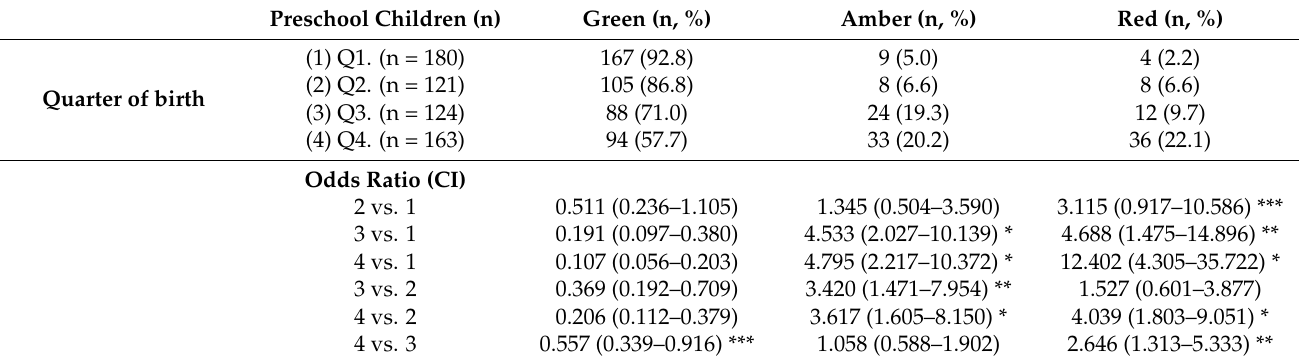
Table 2. Preschool children according to quarter of birth and traffic light zone of the MABC-2